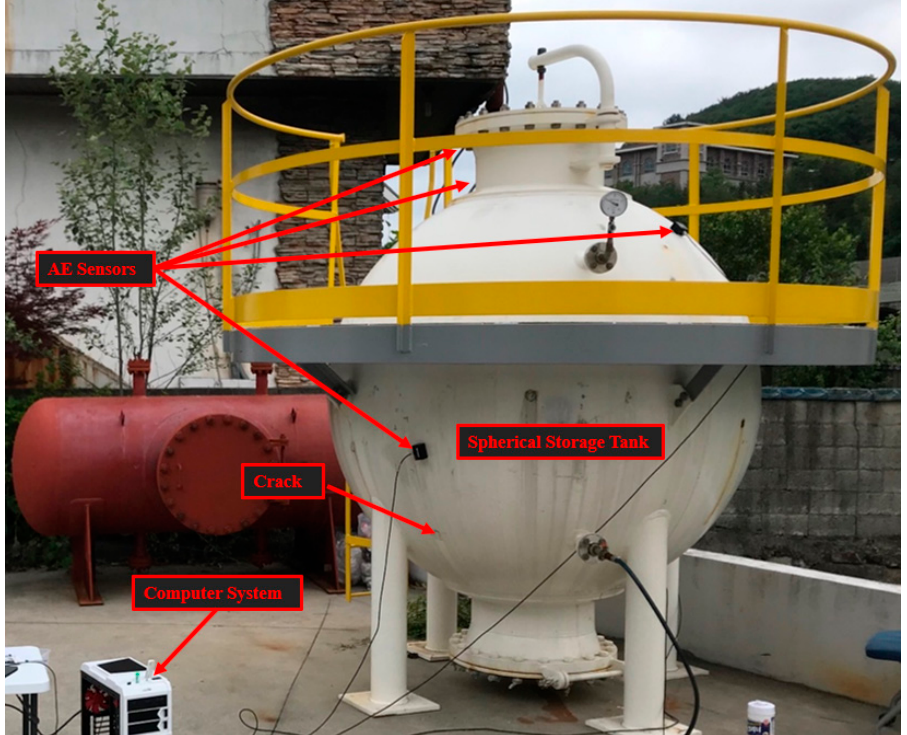
Figure 4. Testbed used to collect acoustic emissions in the experiment.